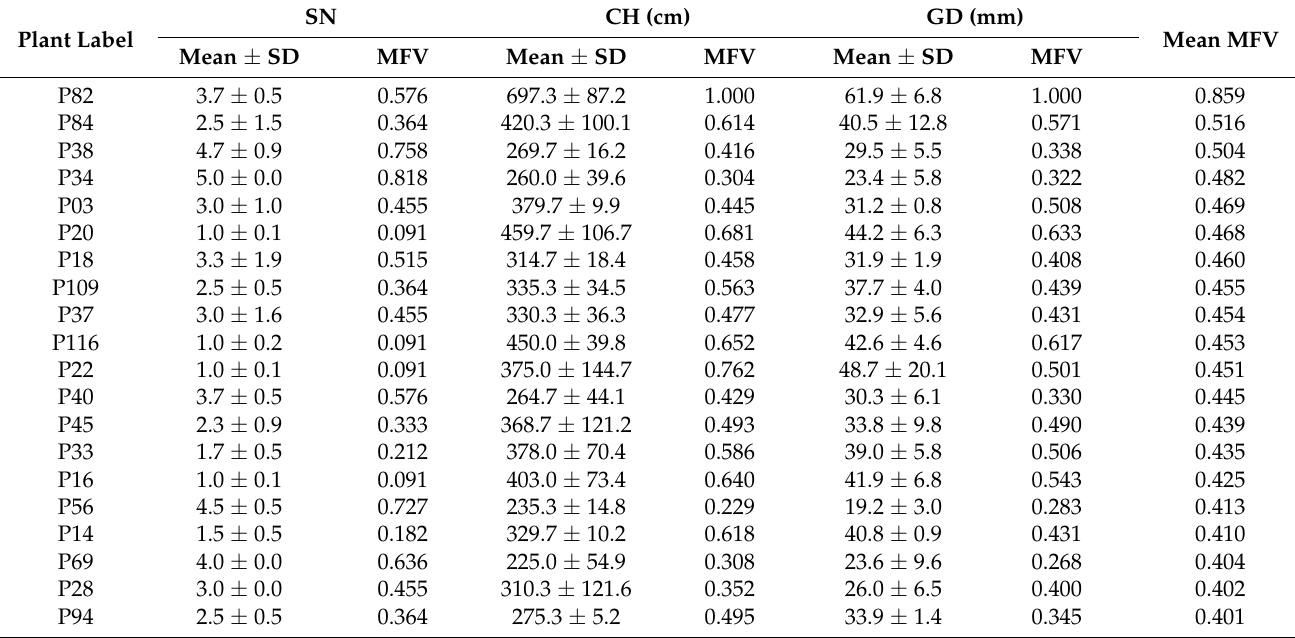
Figure 1. Distribution of mean shoot number (SN) ( a ), mean culm heights (CH) ( b ), and mean ground diameter (GD) ( c ) to the number of regenerated lines after three years of planting. Table 3. Mean and MFV of shoot number (SN), culm heights (CH), and ground diameter (GD) of top 20 regenerated lines after three years of planting.